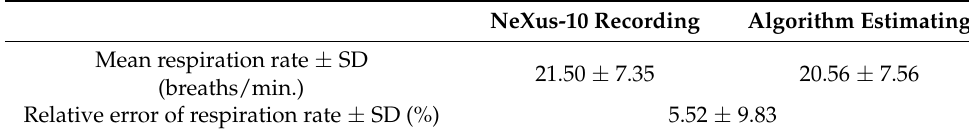
Table 4. ECG-derived respiration algorithm results (clinical patient).